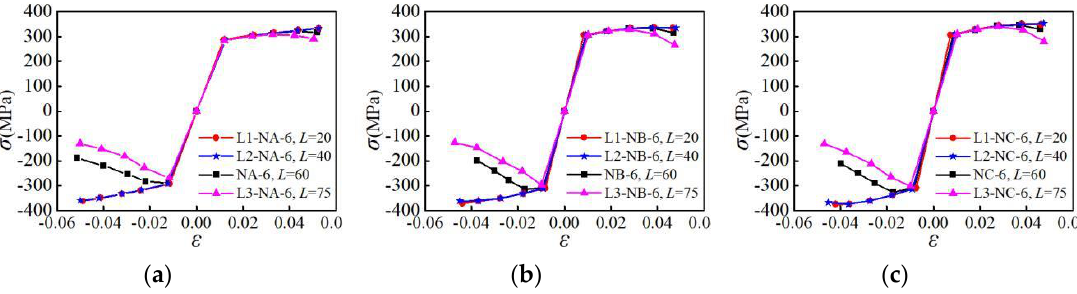
Figure 16. Influence of parallel section length on skeleton curves: ( a ) group A of specimens; ( b ) group B of specimens; ( c ) group C of specimens.